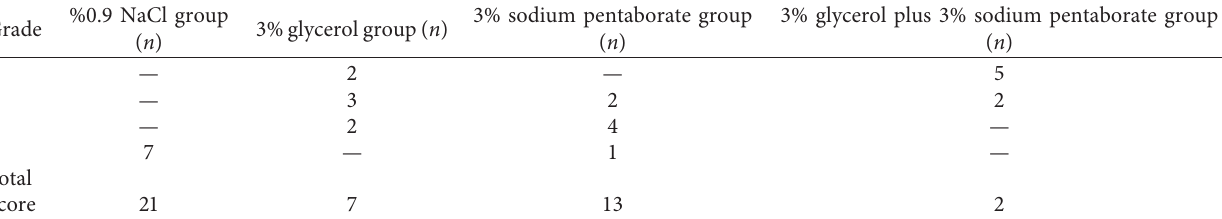
Table 4: Grades of macroscopic adhesion severity.